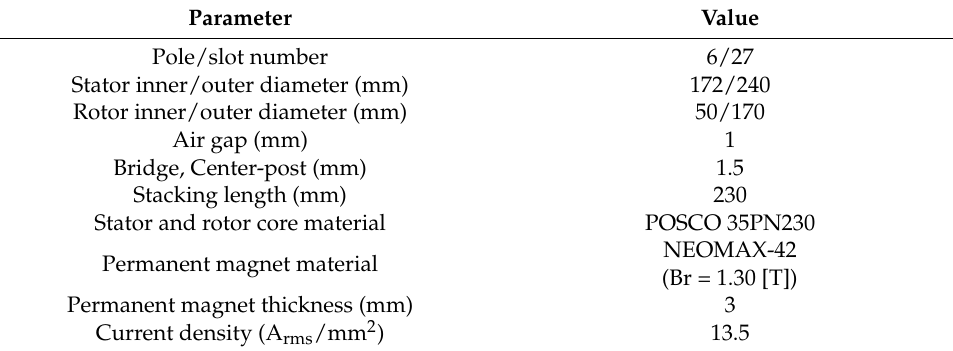
Table 3. Specifications of an objective